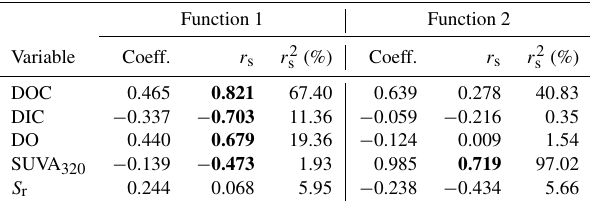
Table 4. The solution for changes in measured independent vari- ables that predict the dependent variable of the lake. Structure co- efficients ( r s ) and communality coefficients greater than | 0 . 45 | are indicated in bold. Note: Coeff. – standardized canonical function coefficient; r s – structure coefficient; r 2 s – squared structure coeffi- cient. Function 1 Function 2 Variable